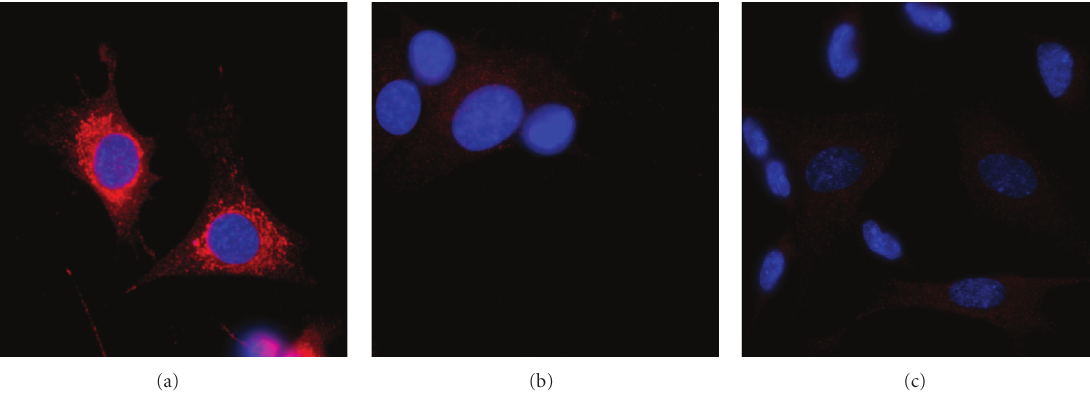
Figure 3: Cellular expression of TOM1L in SK-N-SH neuroblastoma cells examined by confocal microscopy. Confocal imaging of cells stained with antibodies against TOM1L (red) (a), normal rabbit serum (b) or antibodies against TOM1L together with recombinant TOM1L (c). Cells were stained with DAPI (blue) in all images to visualize the localization of the nucleus.